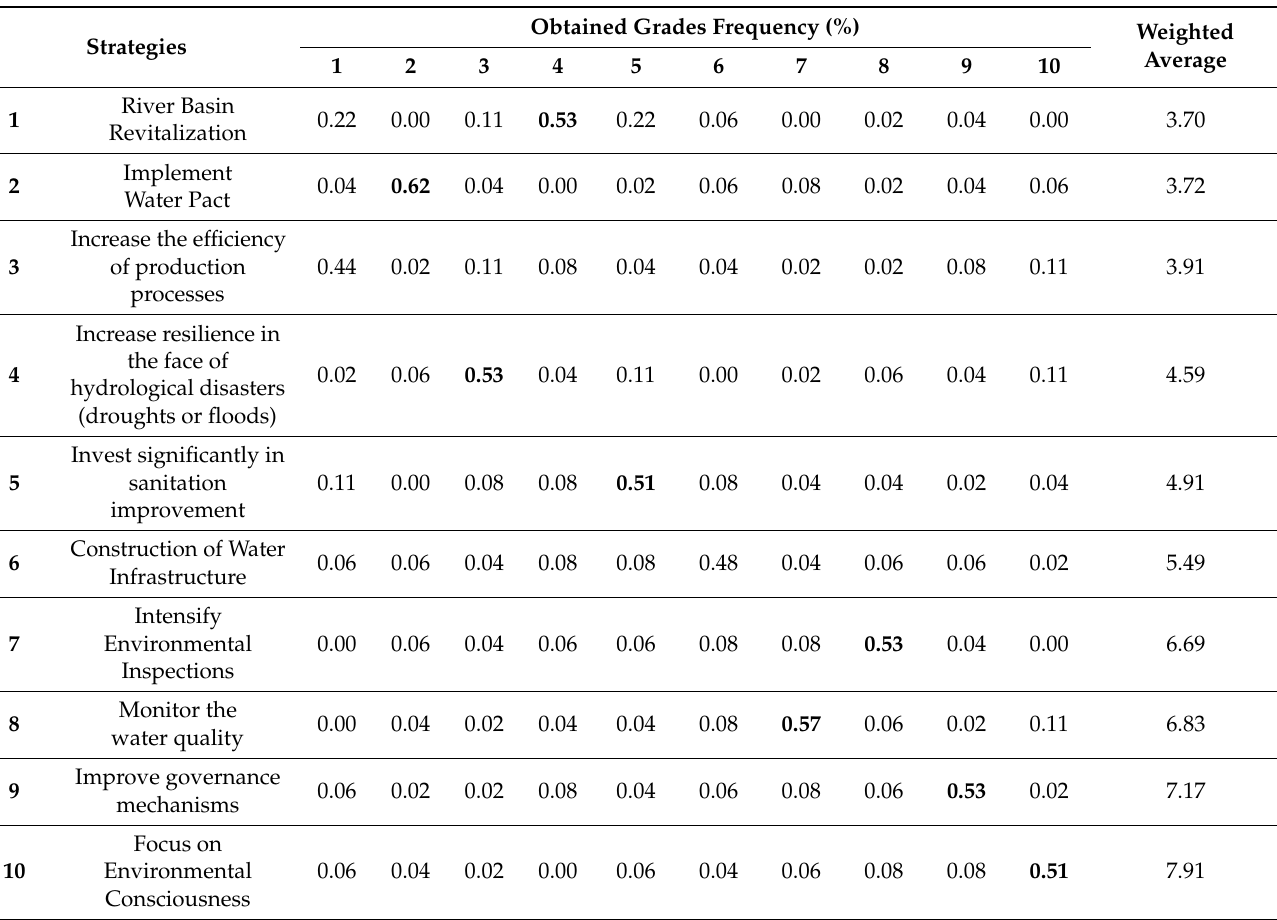
Table 1. Frequency distribution related to the strategy’s hierarchy obtained in the first phase of application of the question- naires to members of the S ã o Francisco River Basin Committee (SFRBC) ( n = 47), with values >50 in bold. Obtained Grades Frequency Strategies